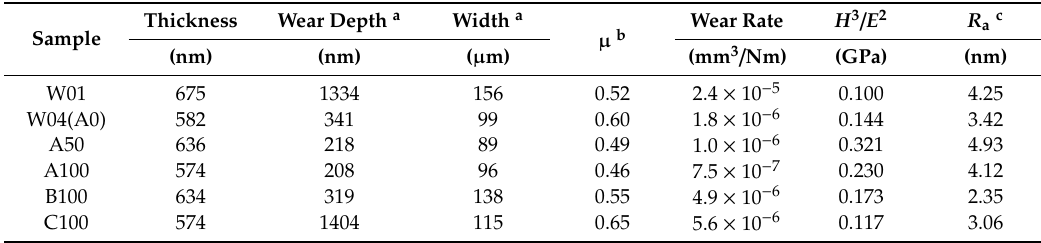
Table 6. Wear test results of the W–N and W–Si–N films.